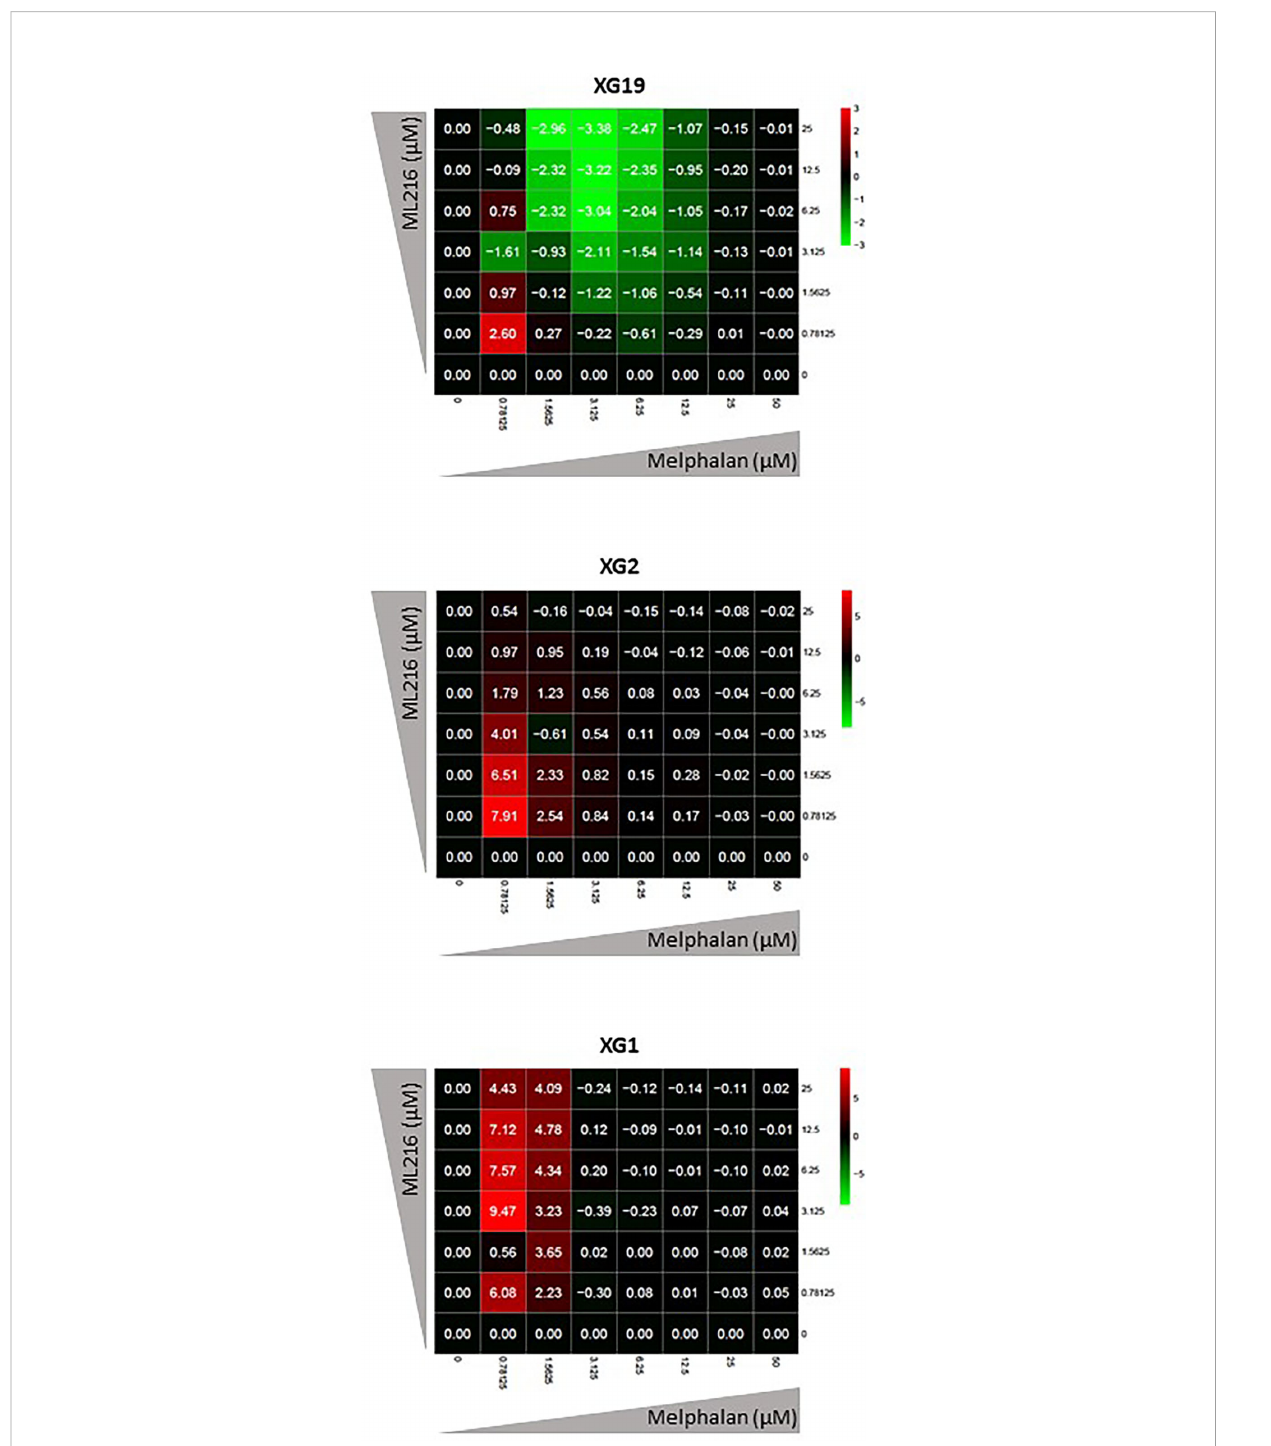
FIGURE 6 ML216 treatment synergizes with melphalan to inhibit HMCLs proliferation. Dose-response matrixes to measure synergy of ML216 and Melphalan co-treatment. Synergy scores are shown using a continuous pseudo-color scale ranging from bright-green (=antagonism) to bright- red (=synergism). XG19, XG2 and XG1 were treated with increasing concentrations of ML216 (0.78125 – 25 m M), and of the alkylating agent melphalan (0.78125 – 50 m M), for 4 days. Cell viability was assessed using the CellTiter-Glo Luminiscent Cell Viability Assay and was normalized to untreated conditions. Matrixes show the average of 3-4 independent